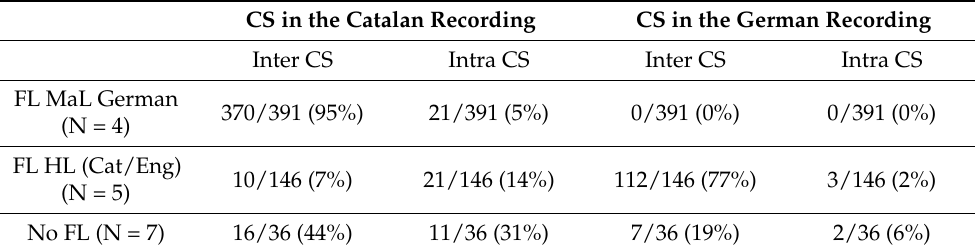
Table 5. Inter- and intrasentential CS and